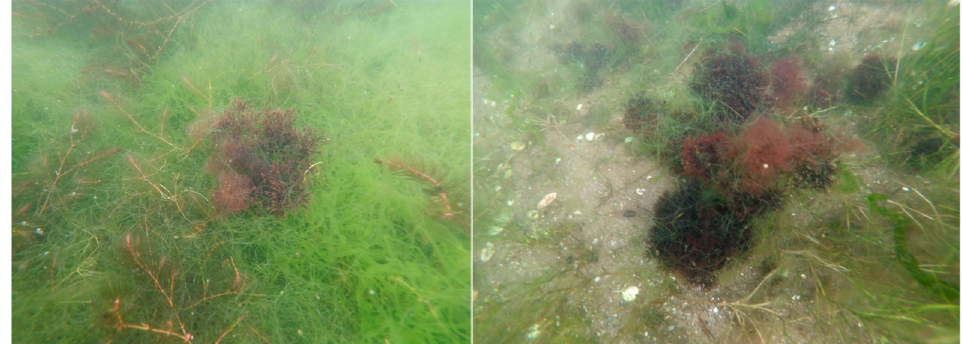
Figure 4. Free-floating thalli of Rhodophyta in Puck Bay in 2019.